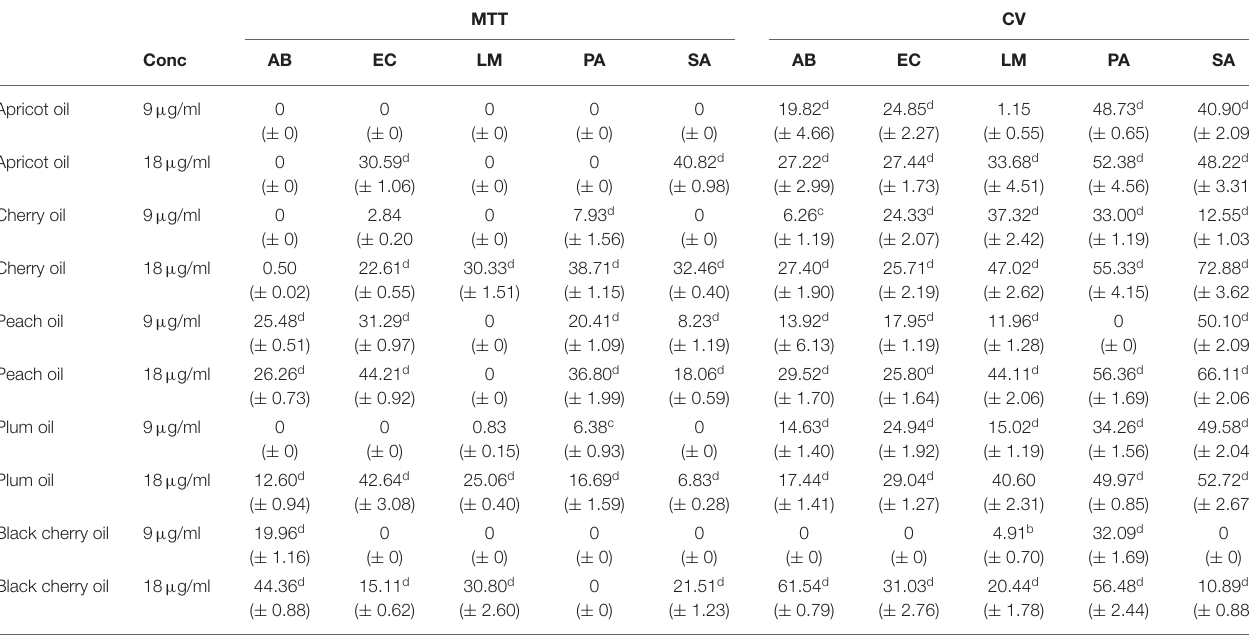
TABLE 7 | Inhibitory activity of the cold-pressed oils of apricot, cherry, peach, plum, and black cherry, tested at 9 µ g/ml and 18 µ g/ml, on the inhibitory capacity on mature biofilm by five pathogenic bacteria. MTT CV Conc AB EC LM